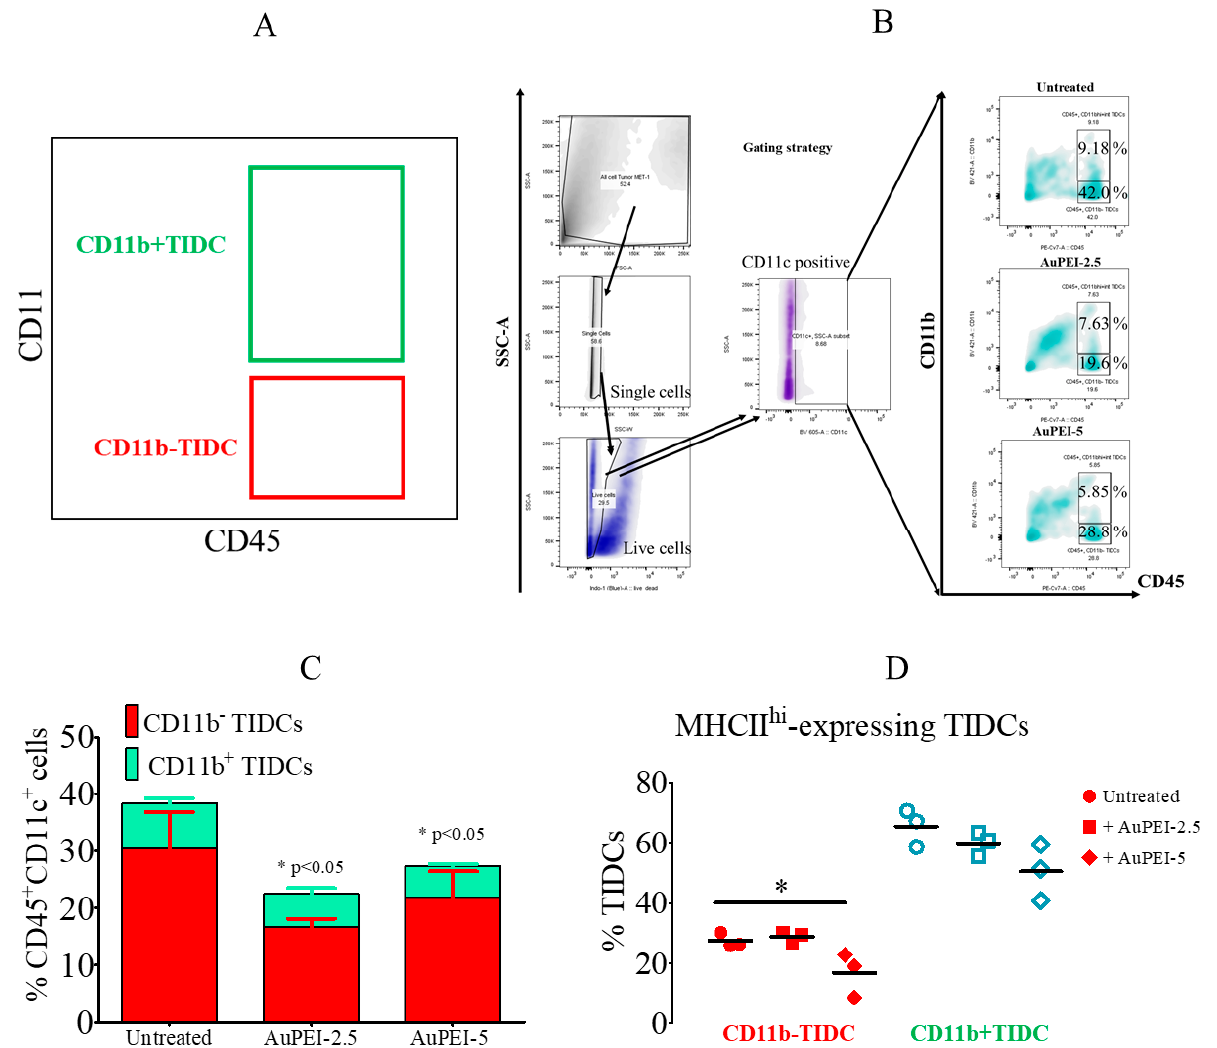
Figure 4. MET-1 tumor-infiltrating DC distribution upon AuPEI nanocomposite i.t. injection. MET-1- bearing mice were injected i.t. with 0.5 mg/mL Au (40 µL) AuPEI nanocomposites and euthanized 24 h after. ( A ) Gating strategy to differentiate TIDCs within the tumor cell population. ( B ) Representative dot-plot showing percentage of different TIDC populations upon AuNP nanocomposite injection, and ( C ) summary of the distribution of TIDC population. ( D ) Activation status of TIDCs as measured by MHCII expression. (Results are shown as mean ± SEM of n = 3 per condition; * p < 0.05 Mann–Whitney test, 95% confidence).